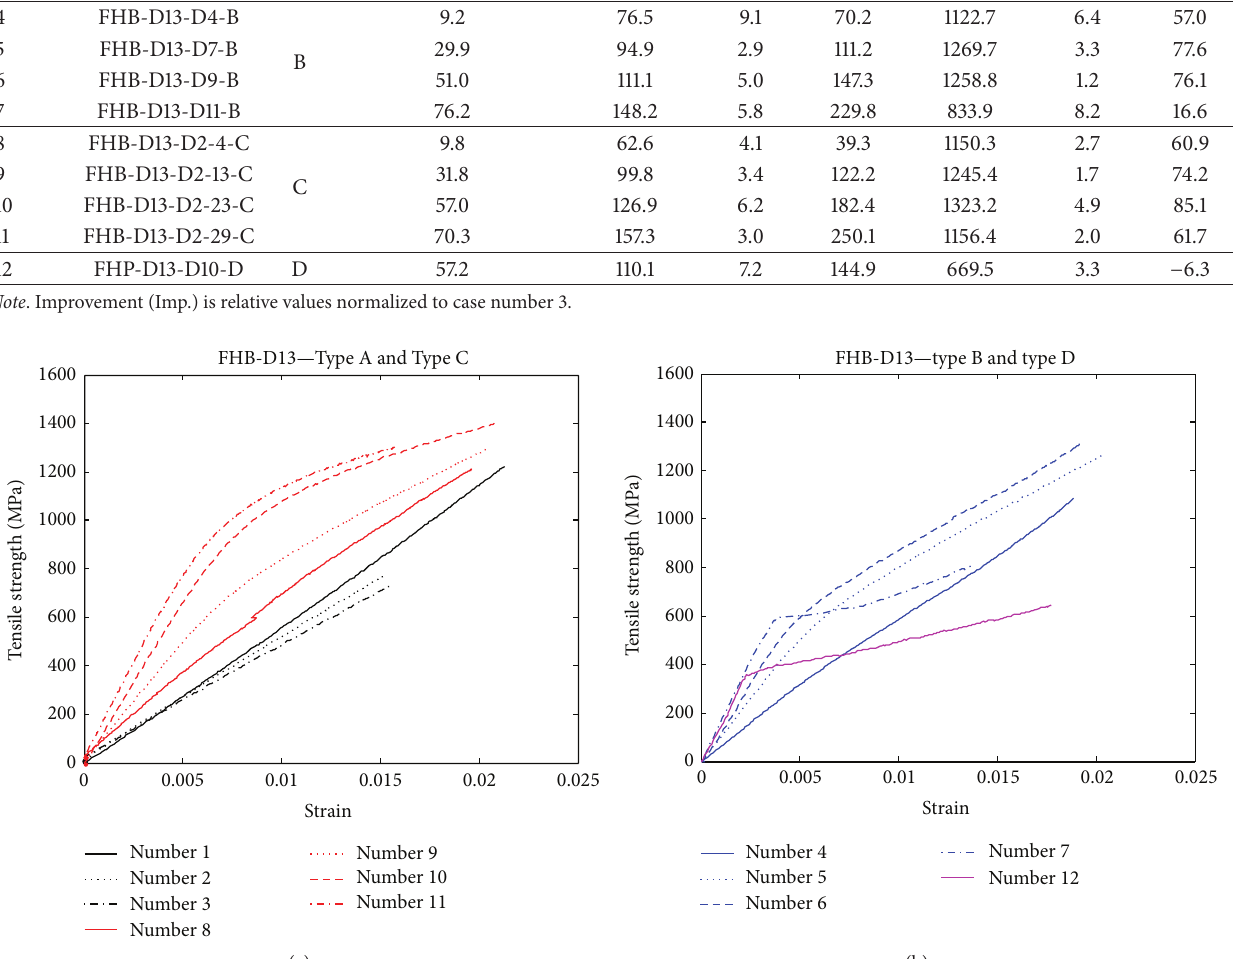
area (i.e., the steel-to-GFRP volume ratio). Error bars